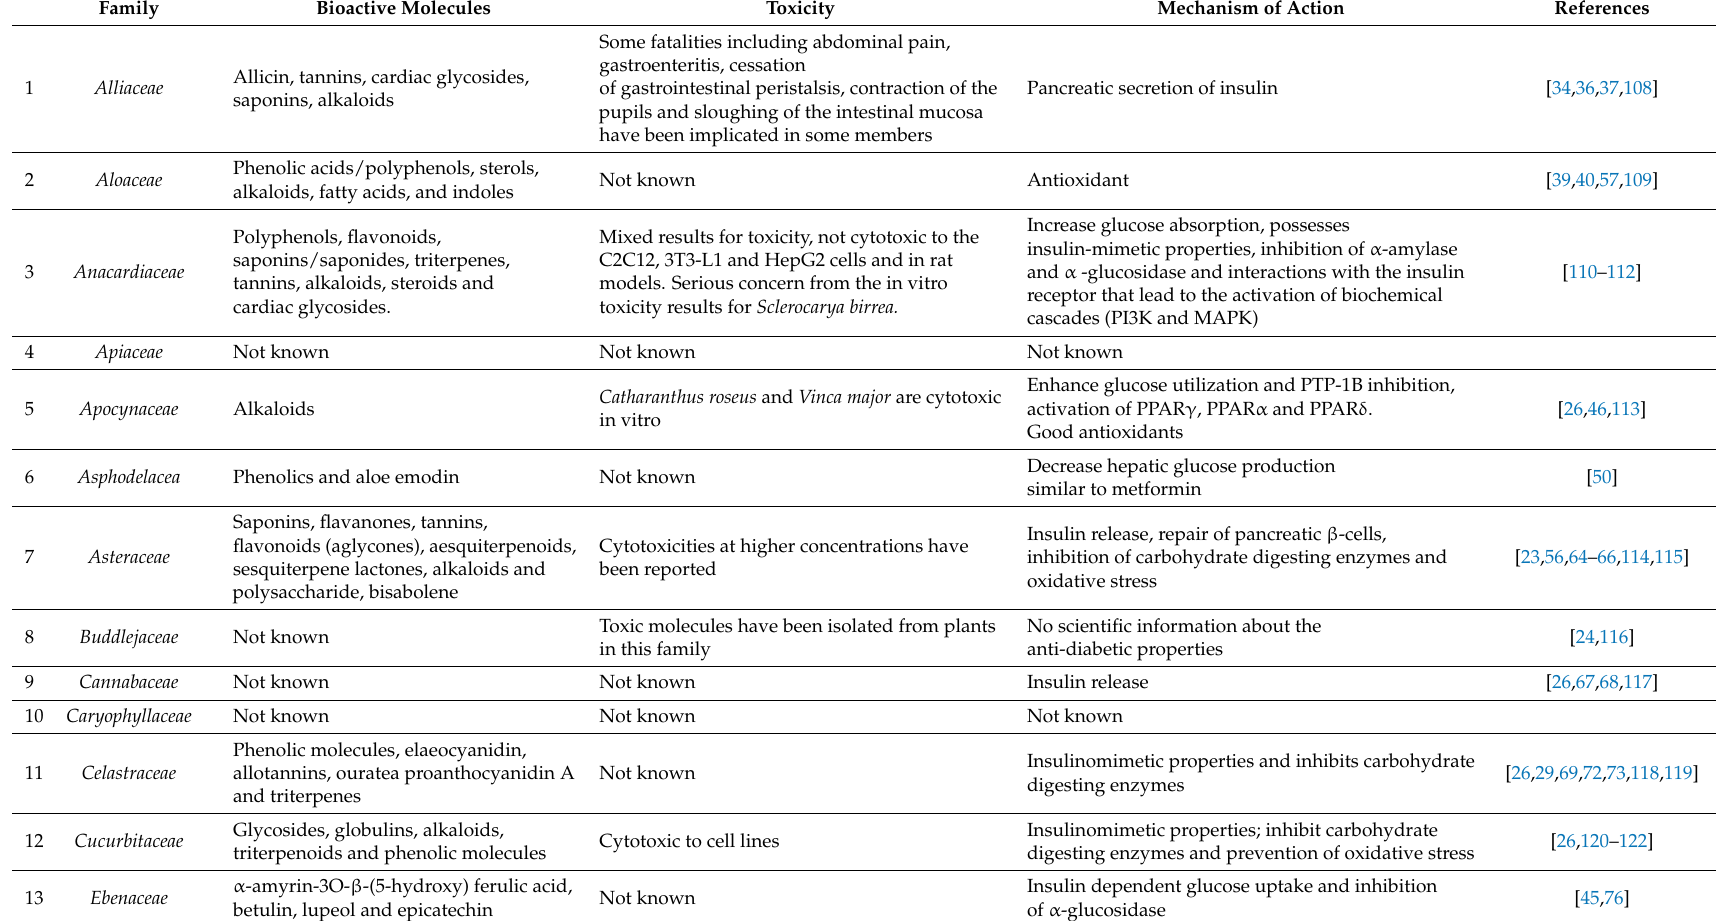
Table 2. Ethno-pharmacological details of plant families used by traditional healers in Eastern Cape, South Africa. PI3K: Phosphatidylinositol-3 kinase; MAPK: mitogen-activated protein kinase PPAR γ : Peroxisome Proliferator-activated Receptor γ , PPAR α : Peroxisome Proliferator-activated Receptor α and PPAR δ : Peroxisome Proliferator-activated Receptor δ